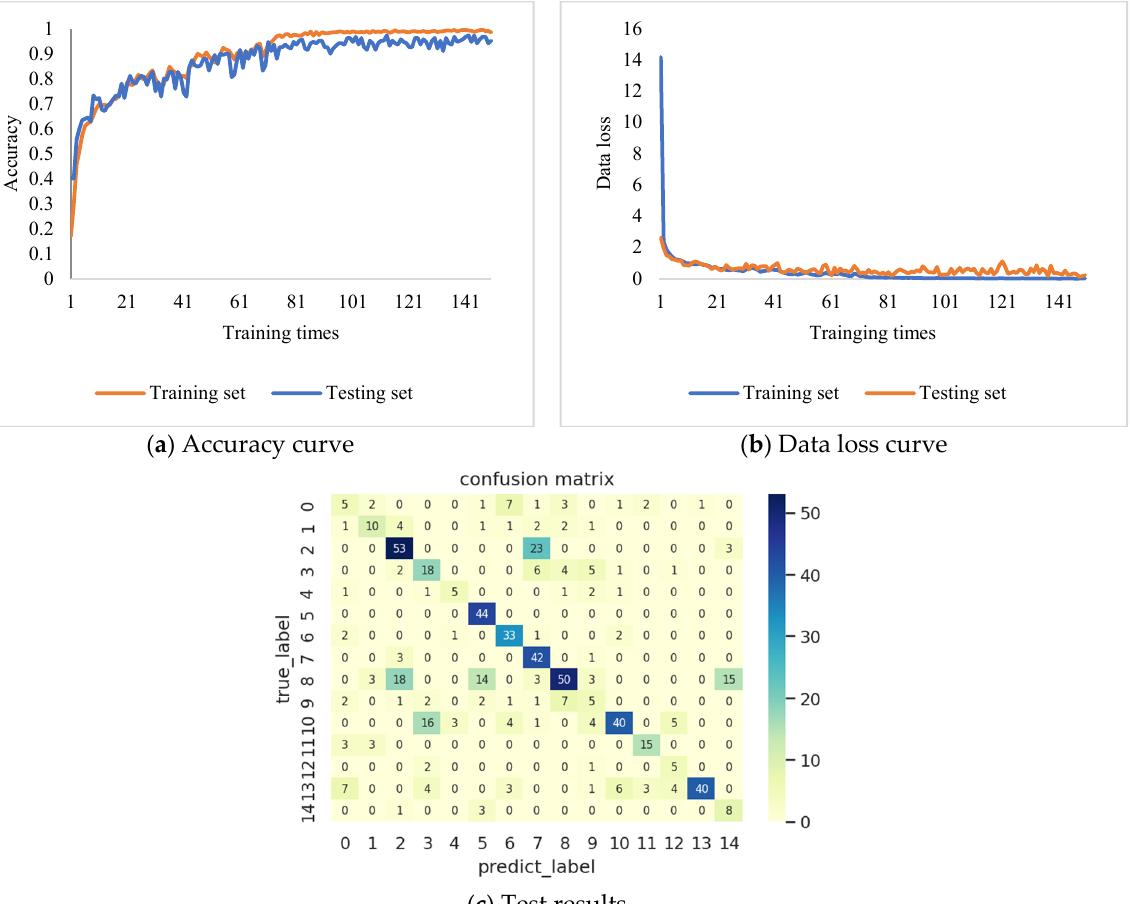
Figure 15. Training results of the transfer learning model based on the Xception model.